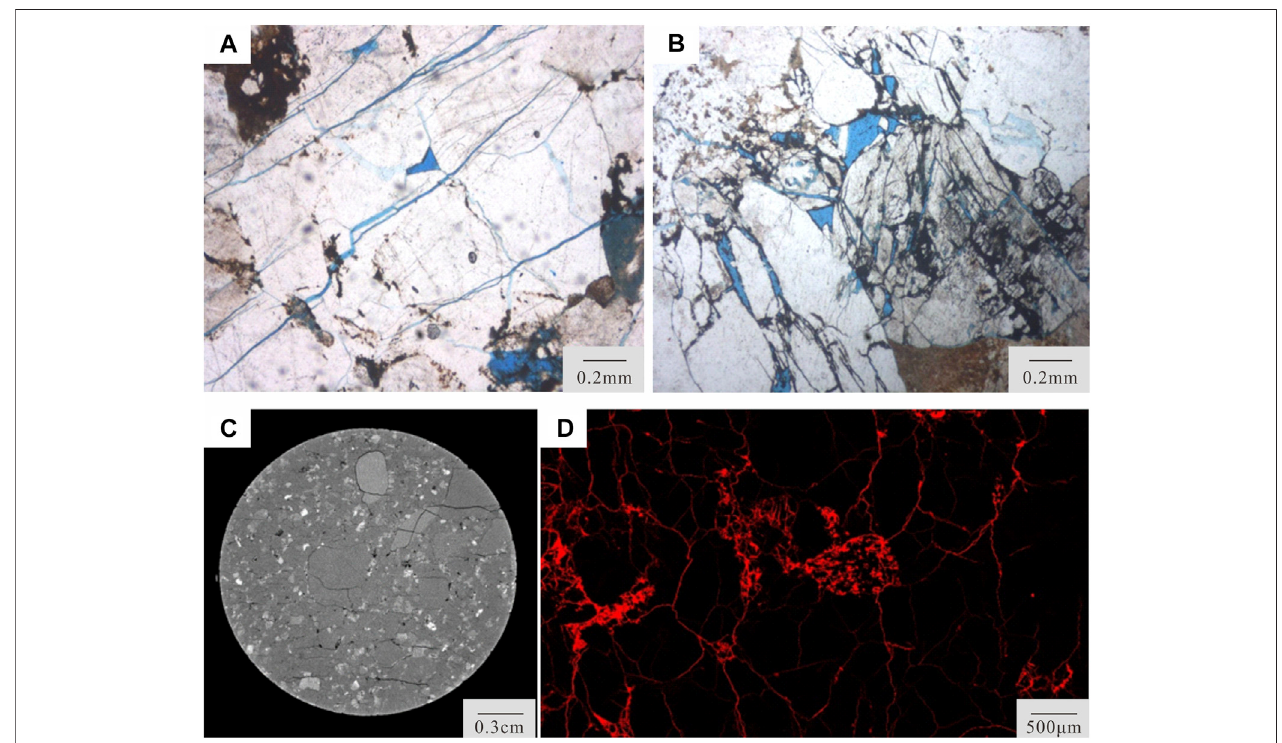
FIGURE3|(A) Wellks2,6,048.73 m,severalmicrofracturesareappearedinthinsection, (B) Wellks2,6,049.56m,aseriesofmicrofracturesinthinsections (C – D) Well ks2, laser confocal and micron CT of well ks2 in the Keshen gas fi eld.